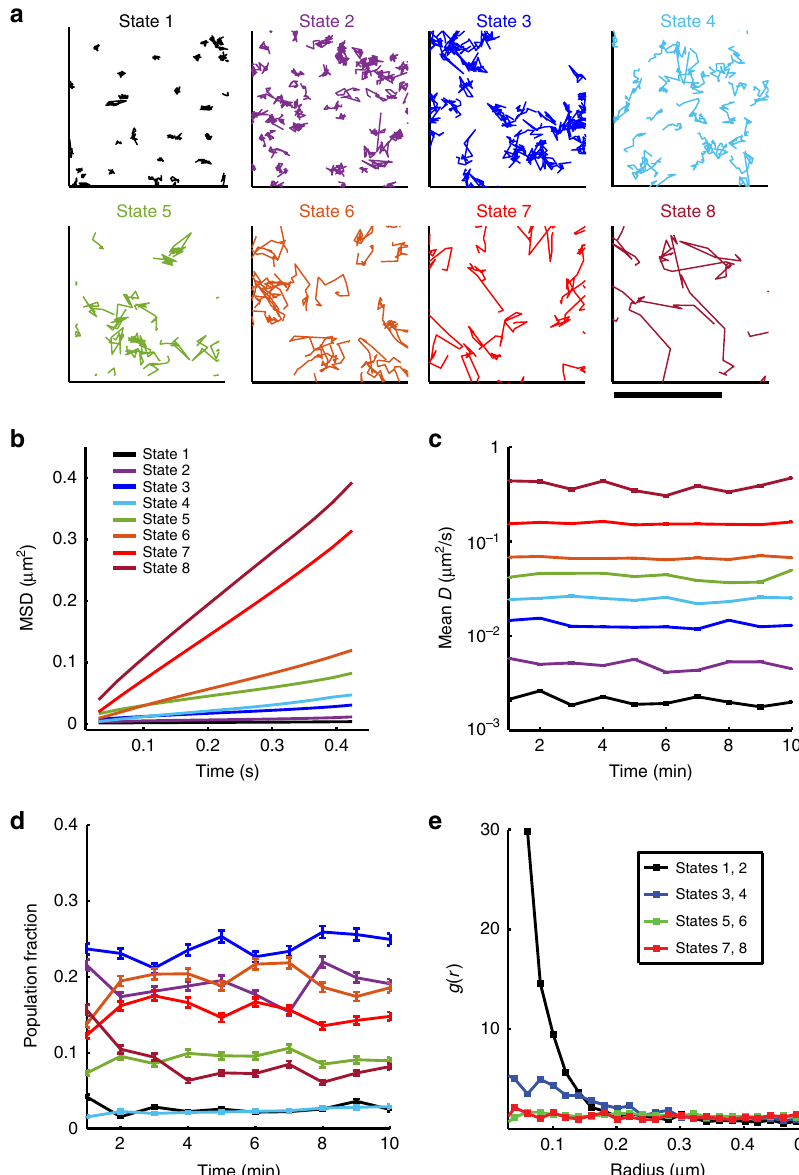
Fig. 2 Perturbation expectation maximization analysis identi fi es eight distinct diffusive states for BCR in control cells. a Characteristic tracks belonging to each of the BCR diffusive states identi fi ed by pEM. Diffusivity increases from State 1 (slowest) to State 8 (fastest). Scale bar is 1 μ m. b Ensemble mean- square displacement (eMSD) plots for each of the states. Colors corresponding to different states are as shown in the legend. ( N = 15 cells). c Plot showing the mean diffusivity for the trajectories belonging to each state at every time point. Error bars represent the standard error of the mean. d Plots showing the fraction of BCR tracks that are sorted in each state at every time point. Error bars represent a con fi dence interval of 95% on the population fraction calculation. e Plot of pair correlation as a function of distance for all states. Source data are provided as a Source Data fi